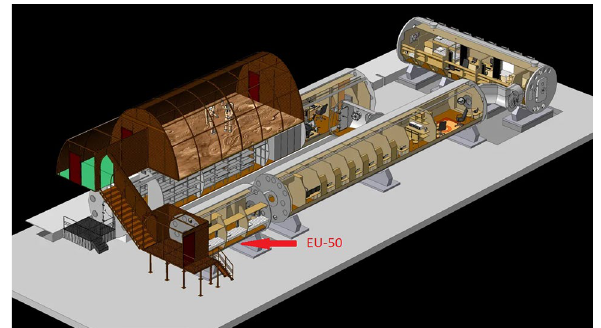
Figure 1. The scheme of the ground-based analog facility (NEK) at the Institute of Biomedical Problems of the Russian Academy of Sciences in Moscow. EU—experimental unit. [Hobihojin H. The transection of the NEK facility. Scheme. IBMP RAS. Mars500 project . [online]: http:// mars5 00. imbp. ru/ nek. html [Accessed 22 Nov